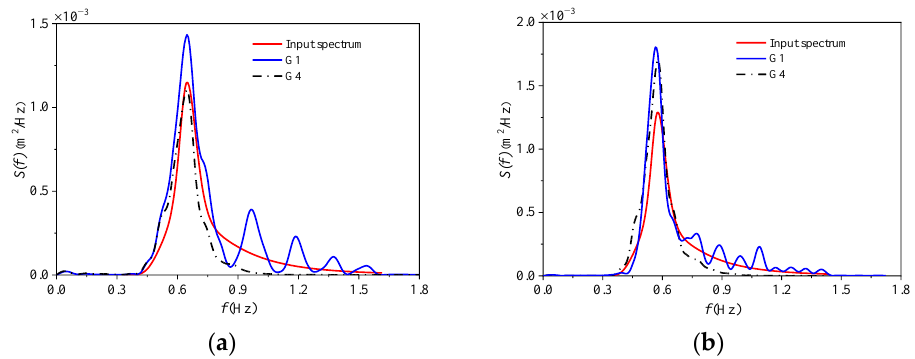
Figure 12. Comparison between wave input spectrum and free surface elevation spectrum at different positions along the NWT. ( a ) k p h = 1.819, ( b ) k p h = 1.258.